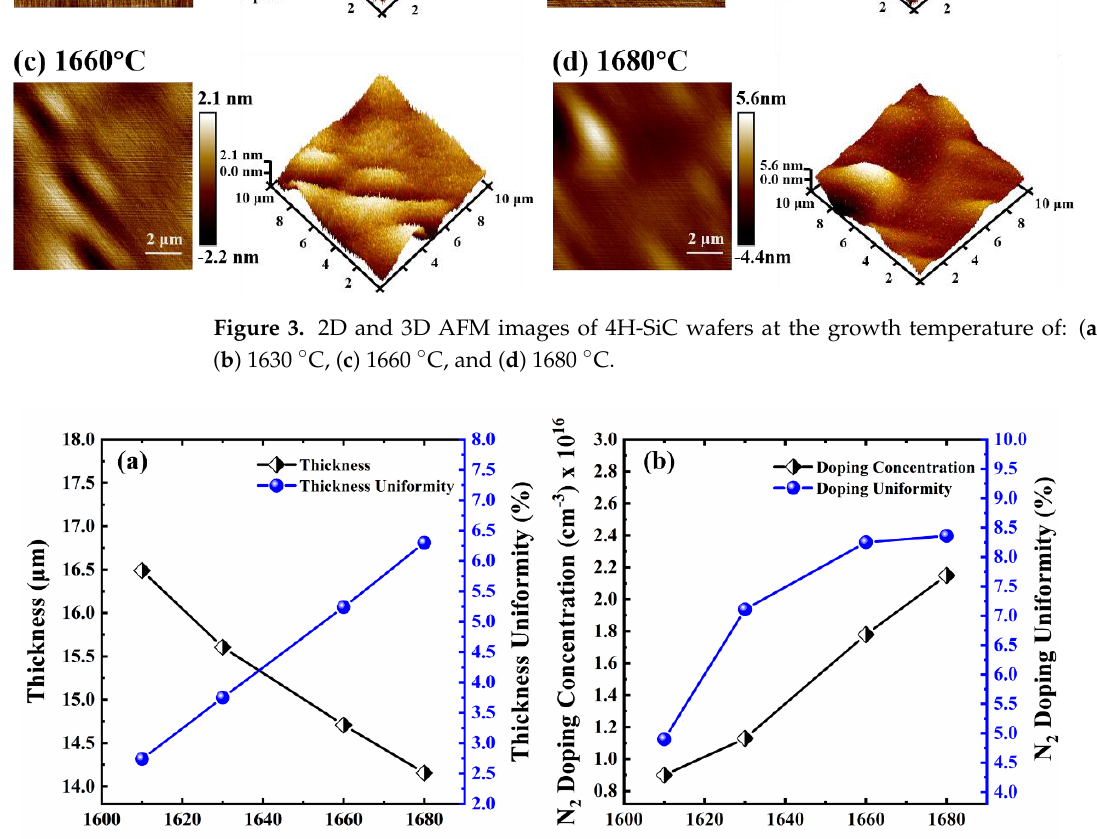
Figure 3. 2D and 3D AFM images of 4H-SiC wafers at the growth temperature of: ( a ) 1610 °C, ( b ) 1630 °C, ( c ) 1660 °C, and ( d ) 1680 °C.